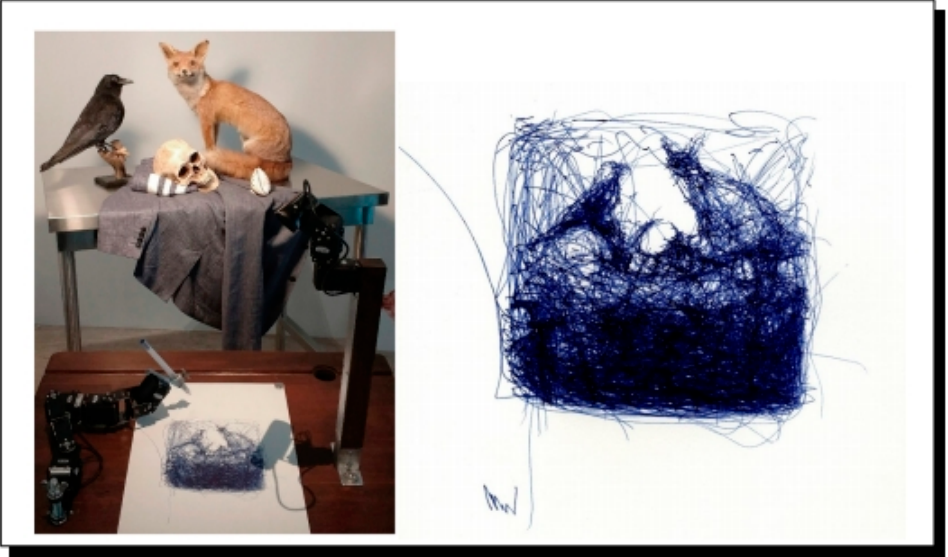
Figure 1. Human Study #2, installation with drawing robots and still life. Image courtesy of Patrick Tresset. Patrick